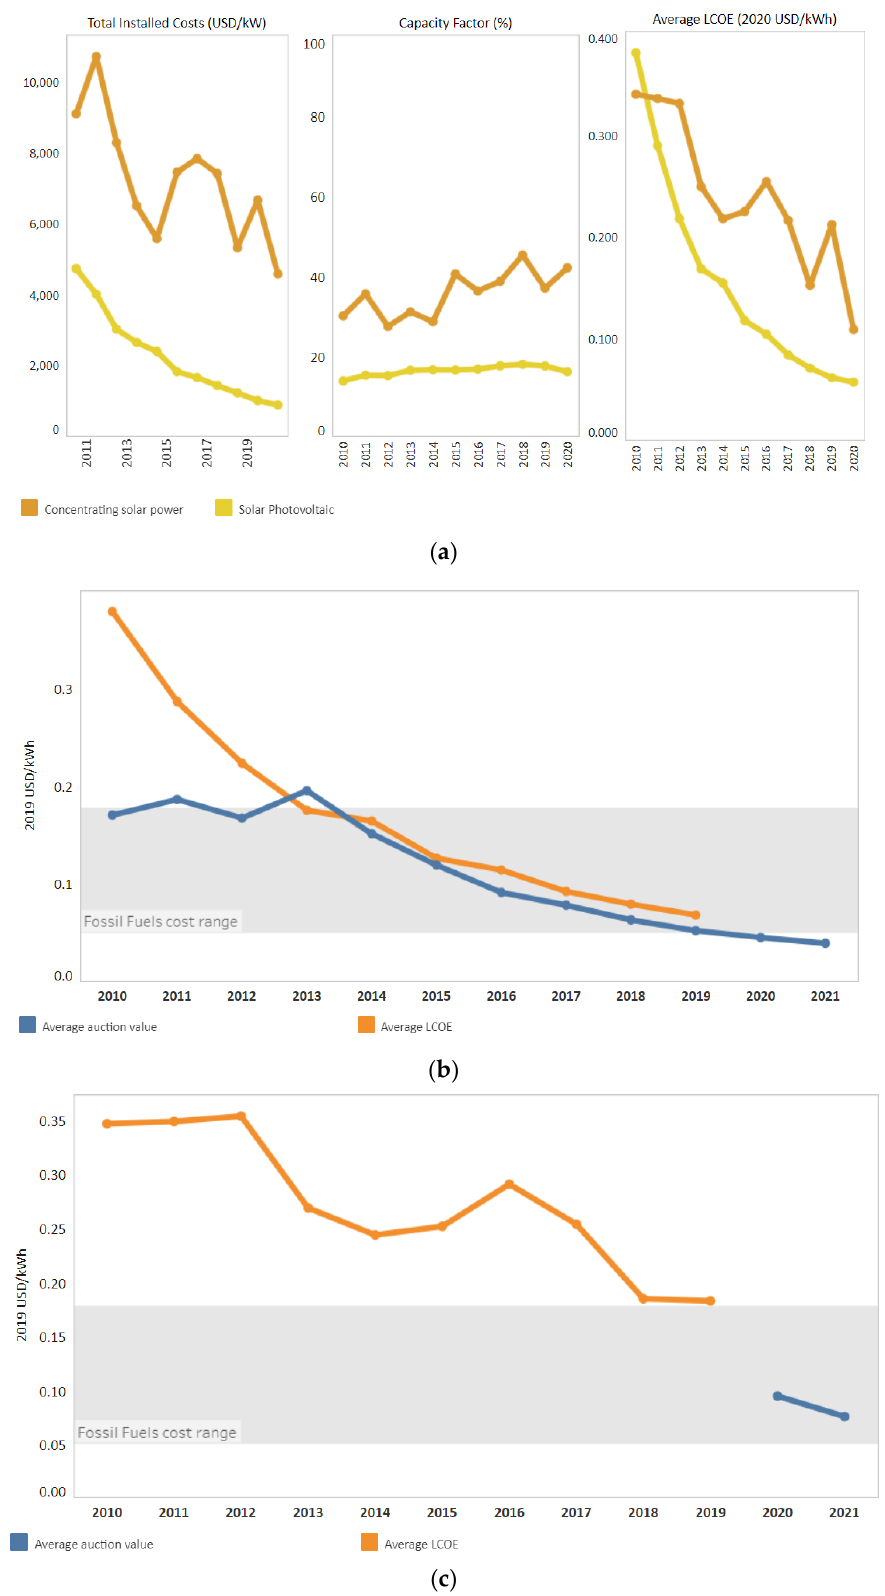
Figure 6. ( a ) Global weighted average total installed costs, capacity factors, and LCOE (2010 – 2020) [46], ( b ) Global weighted average LCOE and auction values of solar PV power (2010 – 2021) [47], ( c ) Global weighted average LCOE and auction values of concentrated solar power (2010 – 2021) [47].